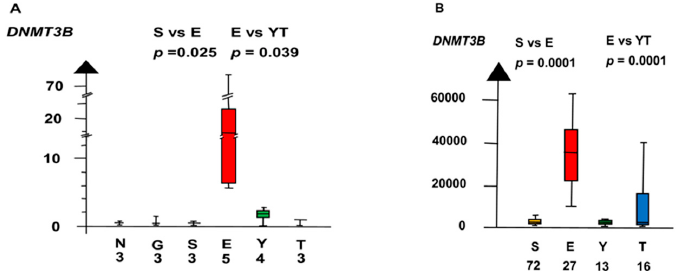
Figure 9. RNA expression of DNMT3B . in the second microarray and the RNAseq dataset ( A , B ) show that embryonal carcinoma (E) had a high RNA expression and that germ cell neoplasia in situ (G), seminoma (S), yolk sac tumor (Y), and teratoma (T) had a low RNA expression. EC had a three times higher RNA expression of LIN28A than SE (2.6 vs. 0.85, p = 0.18, Kruskal– Wallis test), as shown in Figure 10. LIN28A differed stepwise among the histologic types. SE and EC combined had a six times higher RNA expression of LIN28A than NT and GCNIS combined (median 2.4 vs. 0.36, p = 0.0019, Kruskal–Wallis test).